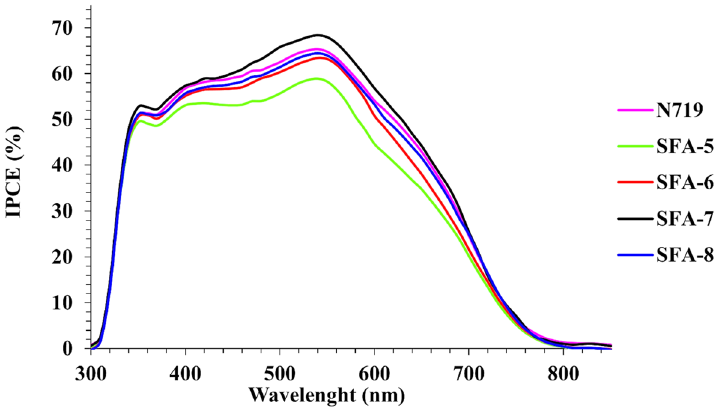
Figure 10. Incident-photon-to-current conversion efficiency (IPCE) spectra for all studied SFA-5–8 sensitizers.